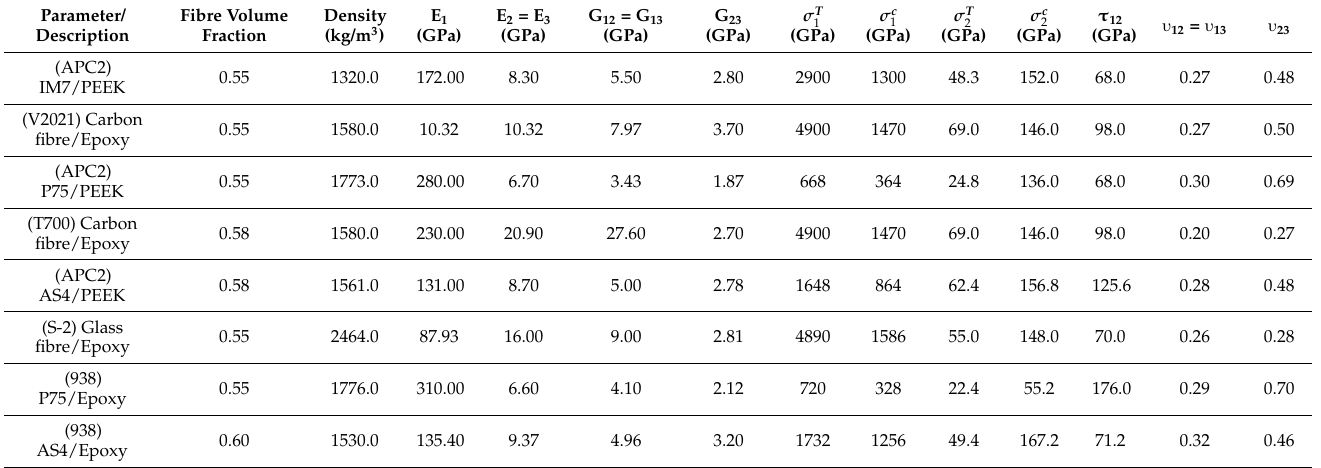
Table 2. Material characteristics for unidirectional FRP